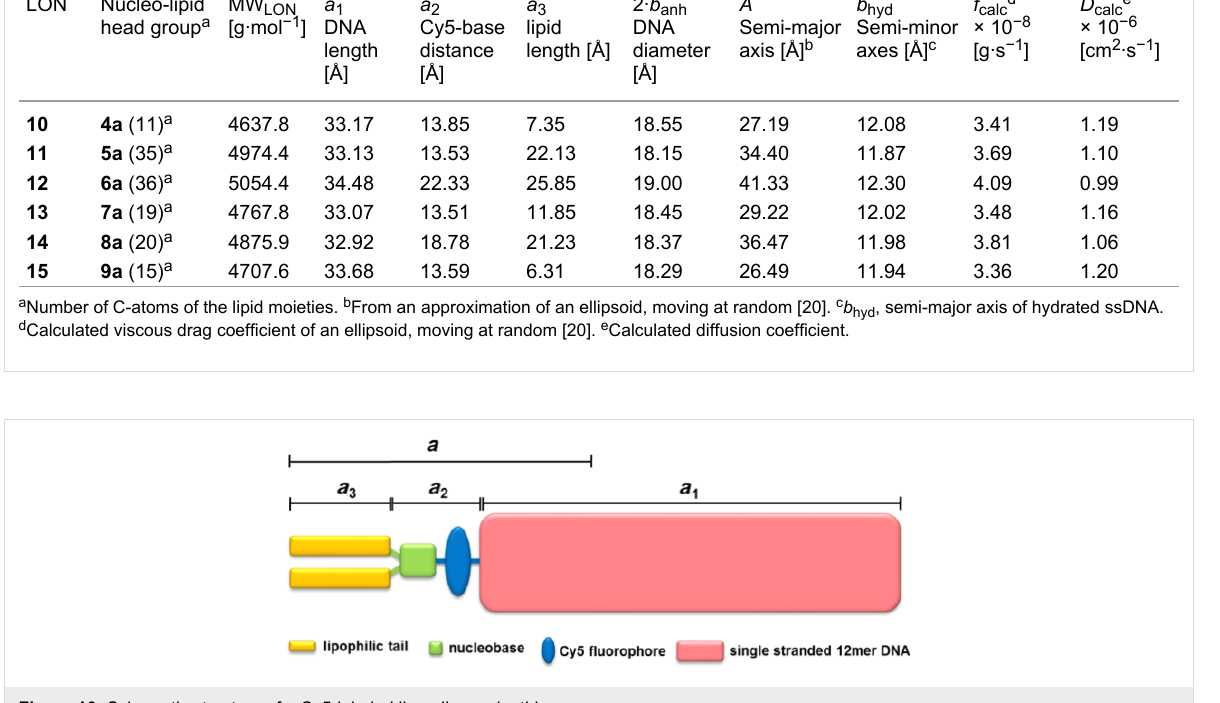
Table 3: Hydrodynamic properties of the lipo-oligonucleotides 10 – 15 . LON